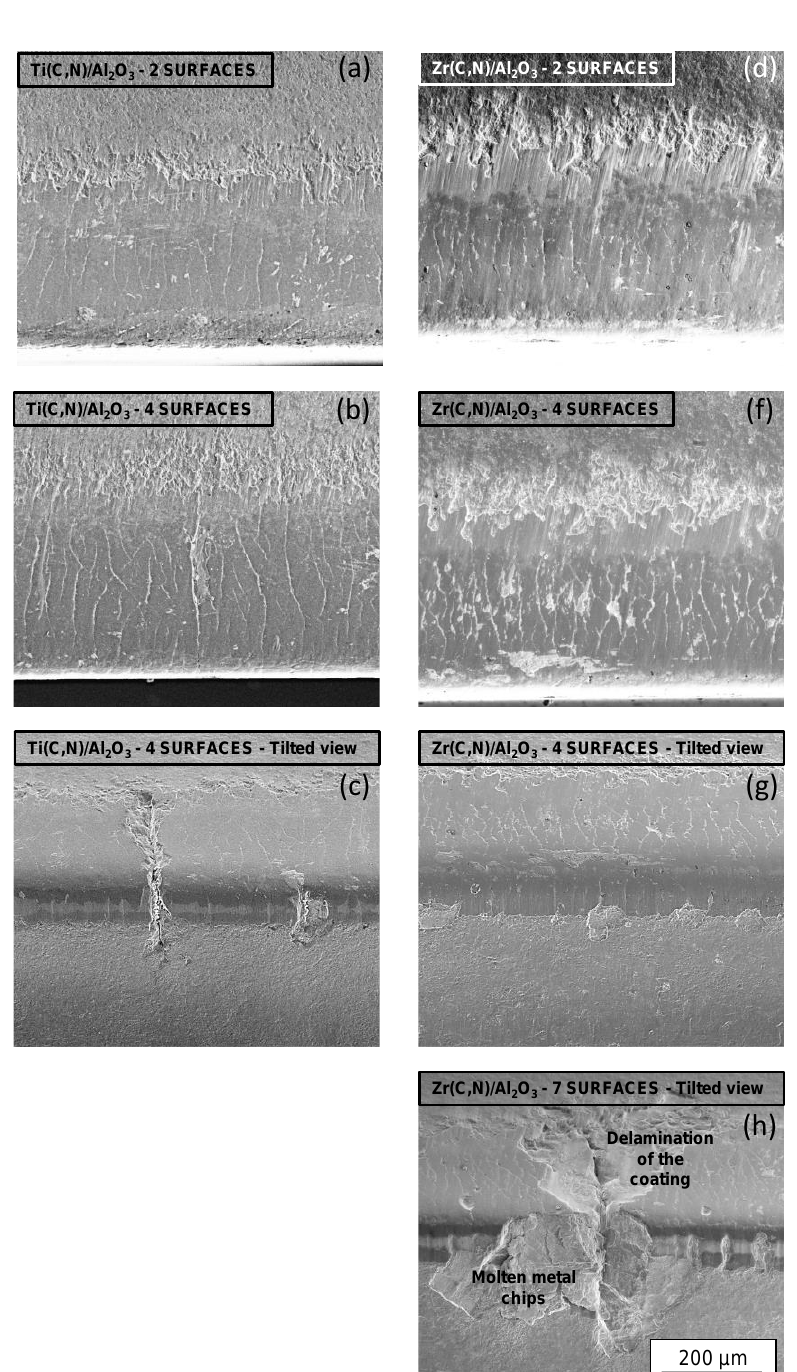
Figure 2. SEM images of the wear evolution for the Ti(C,N)/α-Al 2 O 3 ( a – c ) and Zr(C,N)/α-Al 2 O 3 ( d – h ) systems for same number of milled surfaces. Evolution of comb cracking (starting from the fine cracks) can be seen with the number of milled surfaces. Clear delay in the formation of comb cracks and chipping for the Zr(C,N) based system is observed. The outer surface seen is the α-Al 2 O 3 .